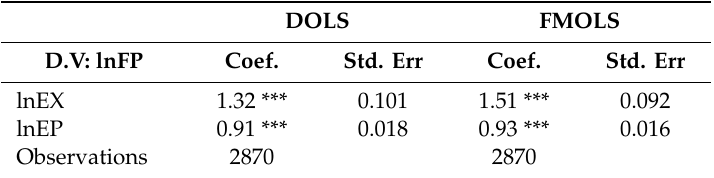
Table 5. Dynamic Ordinary Least Squares (DOLS) and Fully Modified Ordinary Least Square (FMOLS) estimation results.